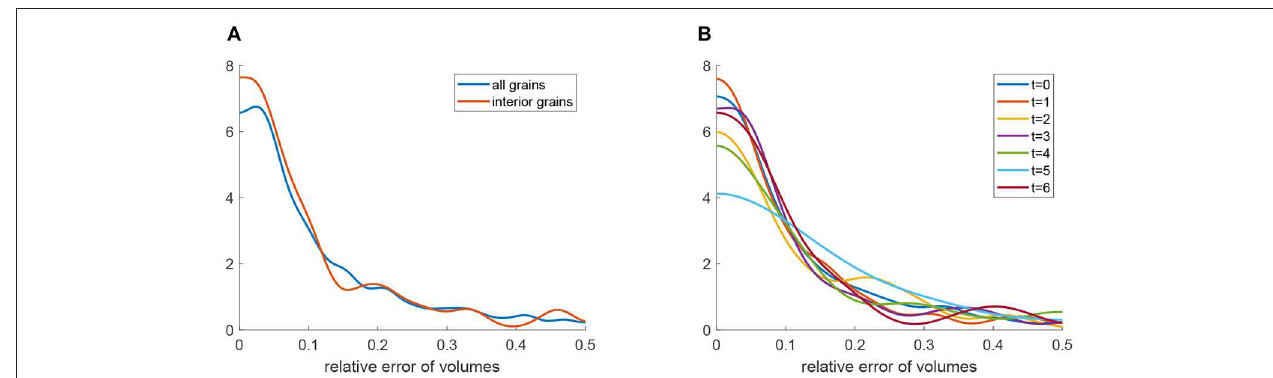
FIGURE 14 | Segmentation results obtained by a 3D U-Net that was trained only with CT/3DXRD data from time step t = 6. (A) Kernel density estimation (blue) of relative errors in grain volume. The red curve is the density of relative errors in volume under the condition that the grain is completely visible in the cylindrical sampling window. (B) Kernel density estimation of relative errors in grain volume obtained by the segmentation procedure for each time step t = 0, ... ,6.